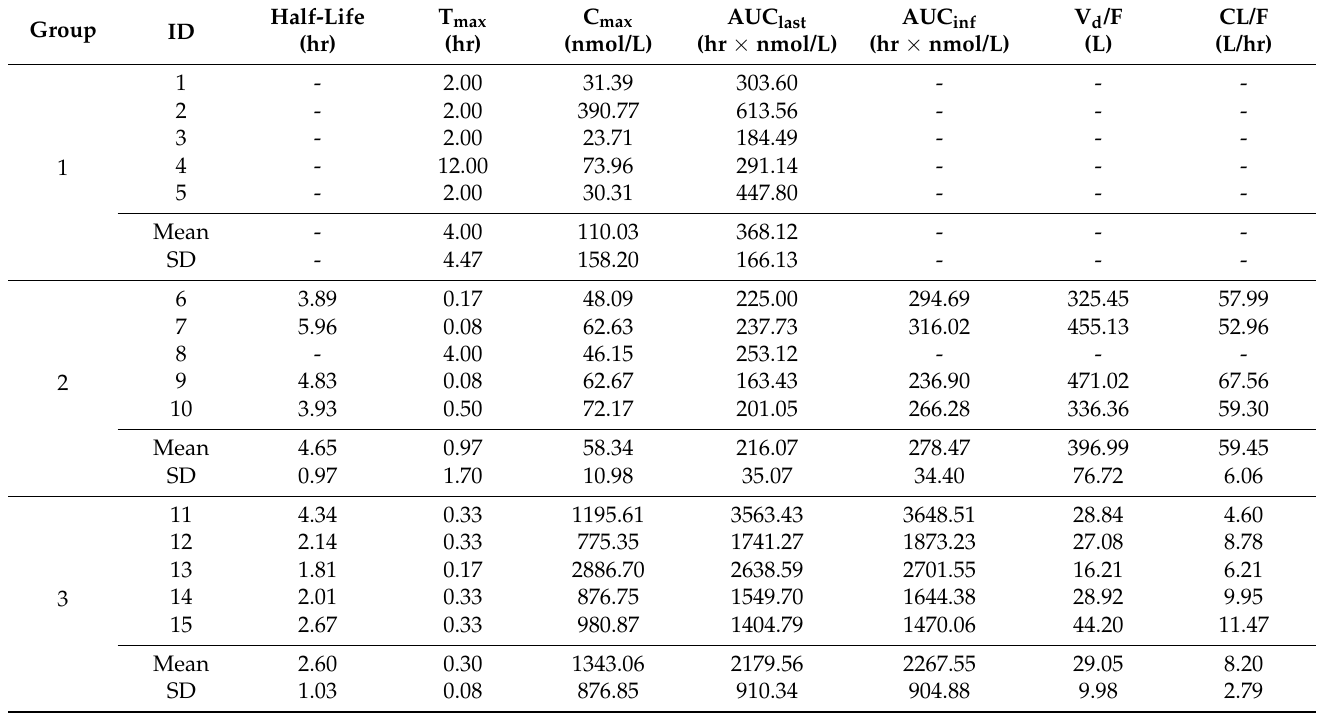
Figure 4. The plasma concentration of ( A ) FMN and ( B ) DZN after oral administration of 20 mg/kg FMN solution (Group 1, □ ), 20 mg/kg FMN co-crystal (Group 2, △ ), and 20 mg/kg FMN solid dispersion (Group 3, ○ ) in Sprague Dawley rats (The error bars in the graph represent standard deviations). Table 3. The estimated pharmacokinetic parameters of FMN.